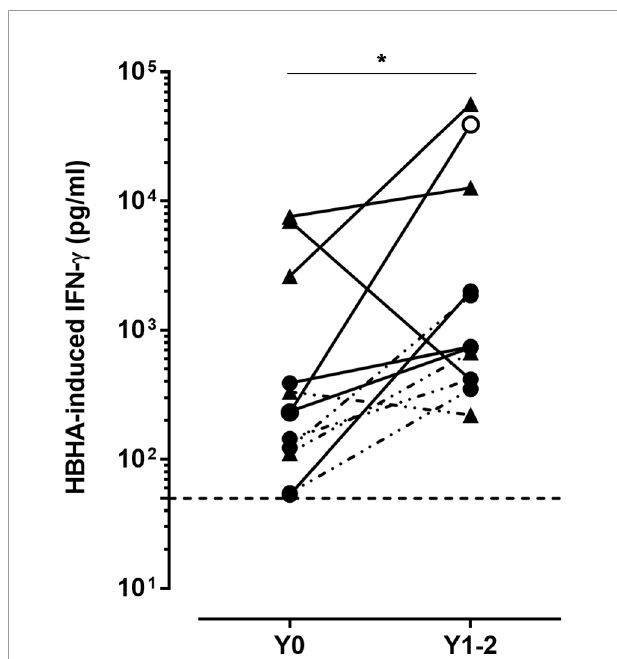
FIGURE 4 | Kinetics of the HBHA-induced IFN- g responses. HBHA-induced IFN- g concentrations were measured in 24 h culture supernatants of HBHA- stimulated PBMC, before starting biotherapy (Y0) and 1 to 2 years later (Y1-2) in 12 patients. Triangles represent TST + patients, and circles represent TST − patients. Open circle represents a patient in contact with a TB index case. The lines bridge results from the same patient. Filled lines indicated patients treated with anti-TNF- a antibodies, whereas dotted lines are for patients treated with anti-IL-23 antibodies. The horizontal dotted line indicates the positivity cut-off for HBHA-IGRA. * p ≤